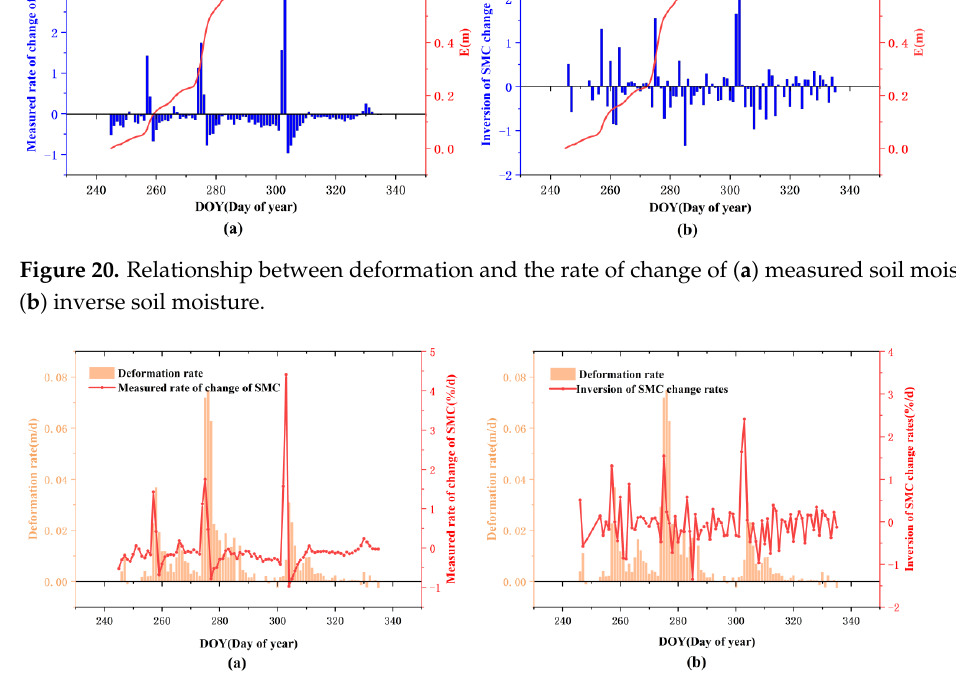
Figure 21. Relationship between rate of deformation and rate of change of ( a ) measured soil moisture; ( b ) inverse soil moisture.